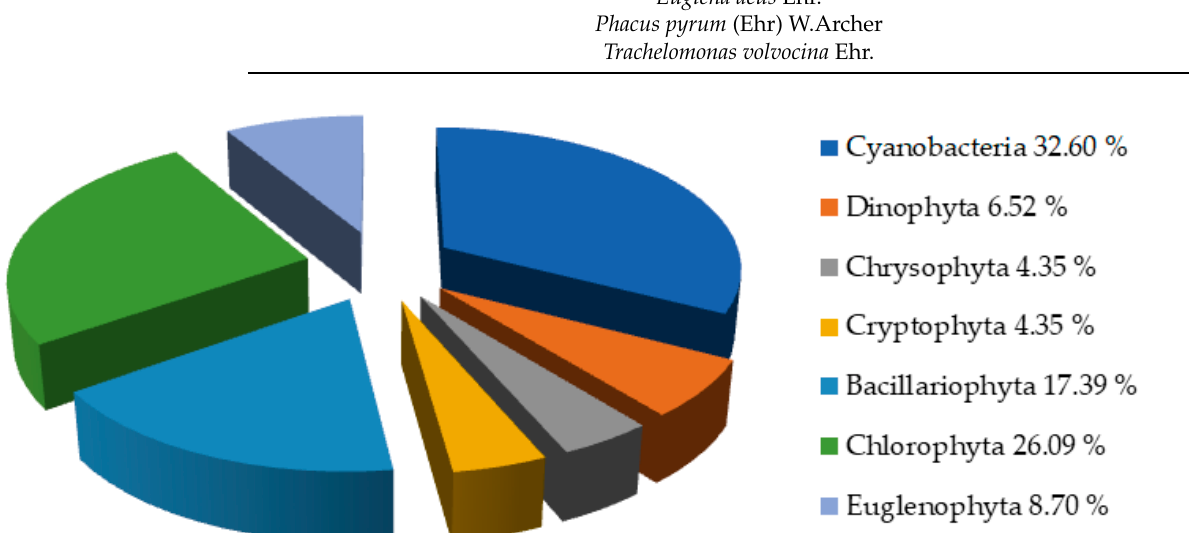
Figure 8. Qualitative analyses of phytoplankton from January to December 2021.